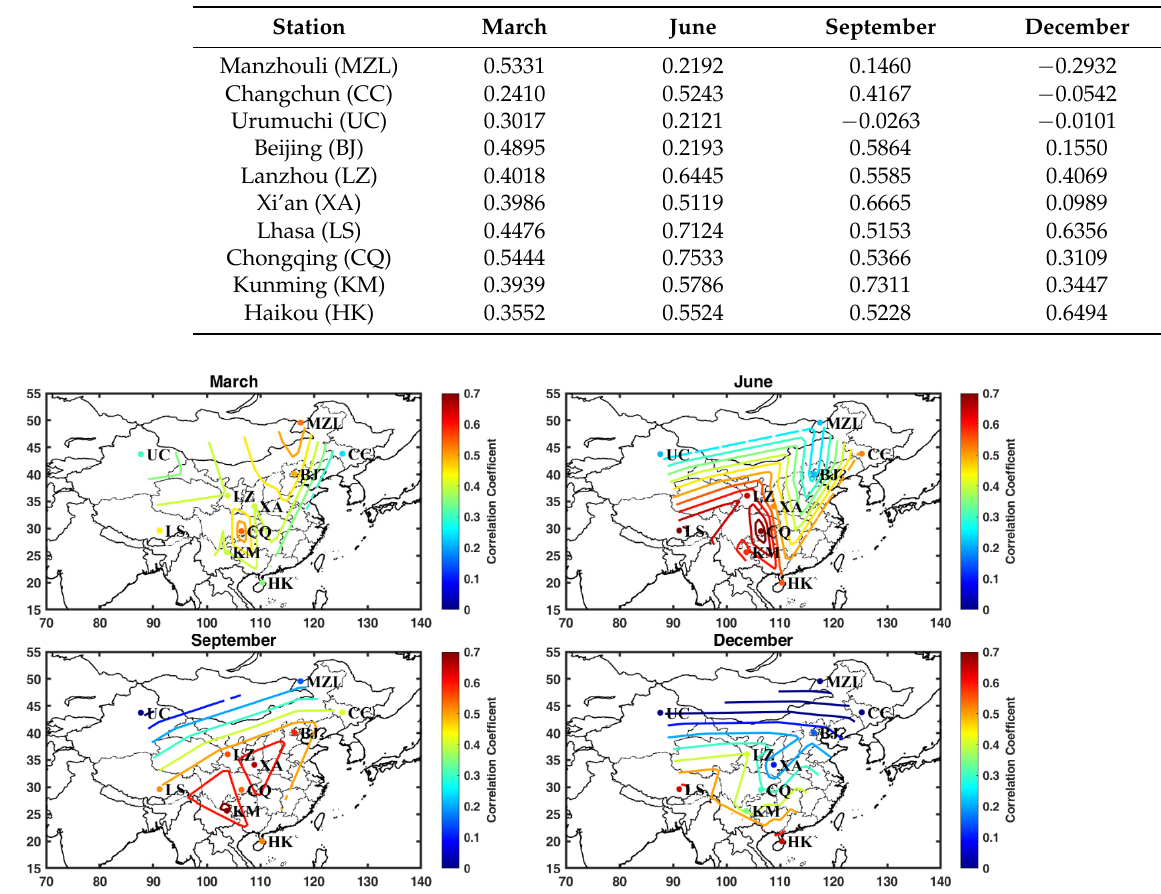
Figure 9. Contour map of correlation coefficient between CSES and ionosonde Ne in different months. Acronyms of station names are used in each panel. The median value of the relative change of the CSES Ne corresponding to the iono- sonde observations (calculated by Equation (1)) for each station is summarized in Table 2. All of the data are negative, which means that the value of the CSES Ne is lower than that of the Ne at the satellite altitude inferred by ionosonde observations and the IRI model at different latitudes. The values are from − 80% to − 95%. In general, the difference between the two datasets is a little larger in December compared to other months, when the corre- lation coefficient is relatively low. Table 2. Median value for relative change of CSES Ne corresponding to ionosonde Ne at different stations. Station